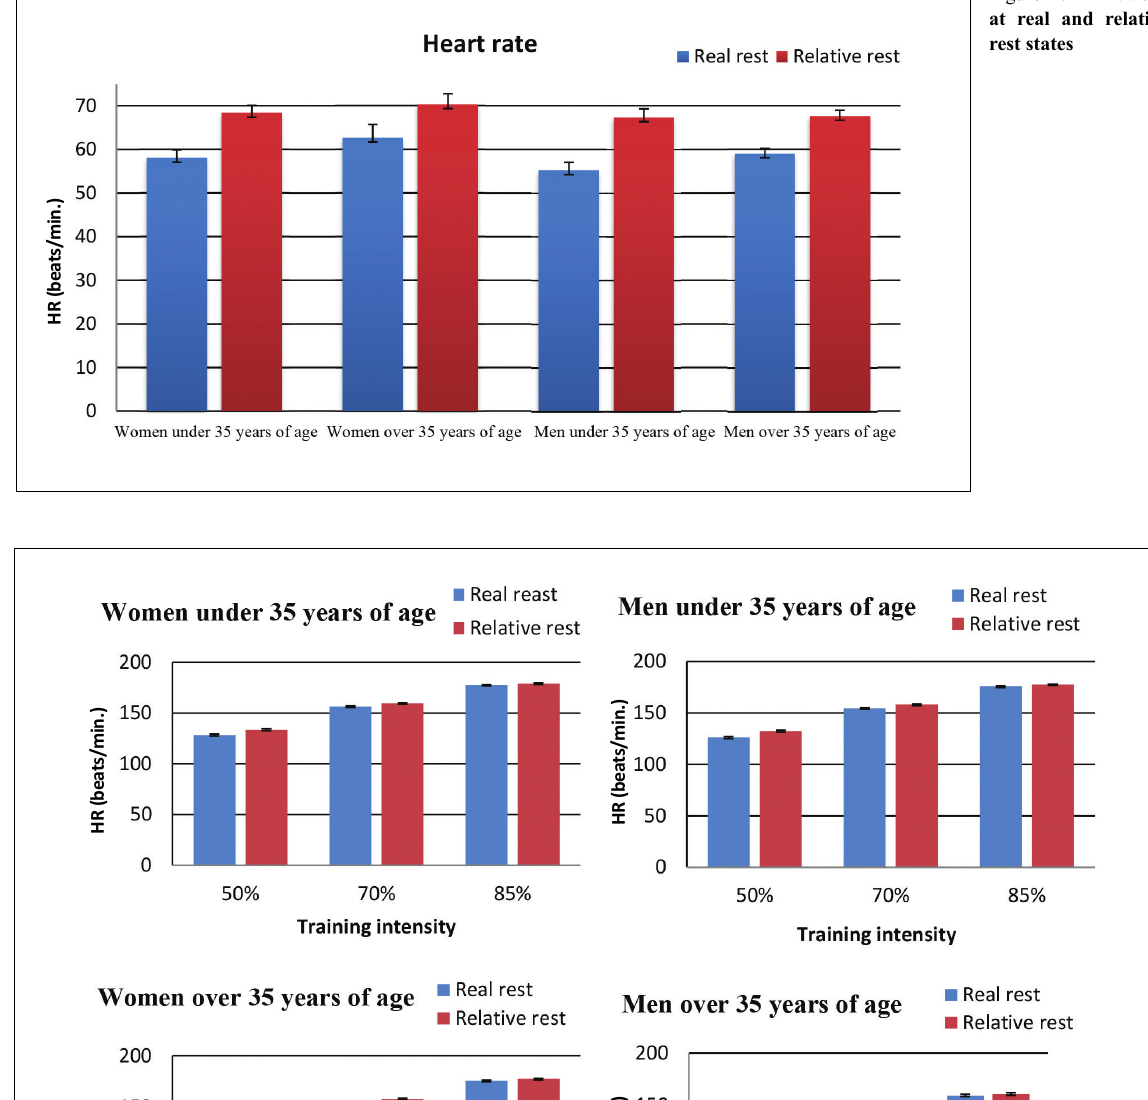
Figure 1. HR values at real and relative rest states